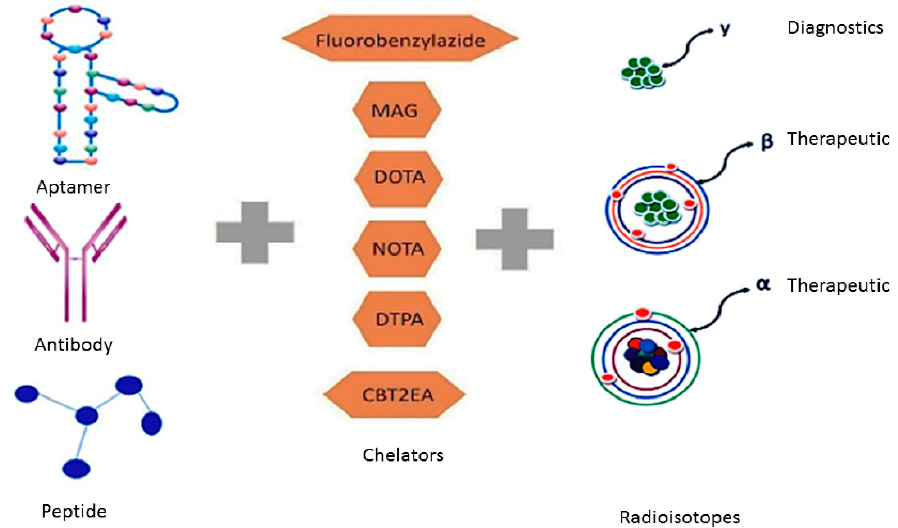
Figure 1. Targeting ligands are conjugated to a chelator which can bind a radioisotope that can be used for diagnostics or therapeutics.